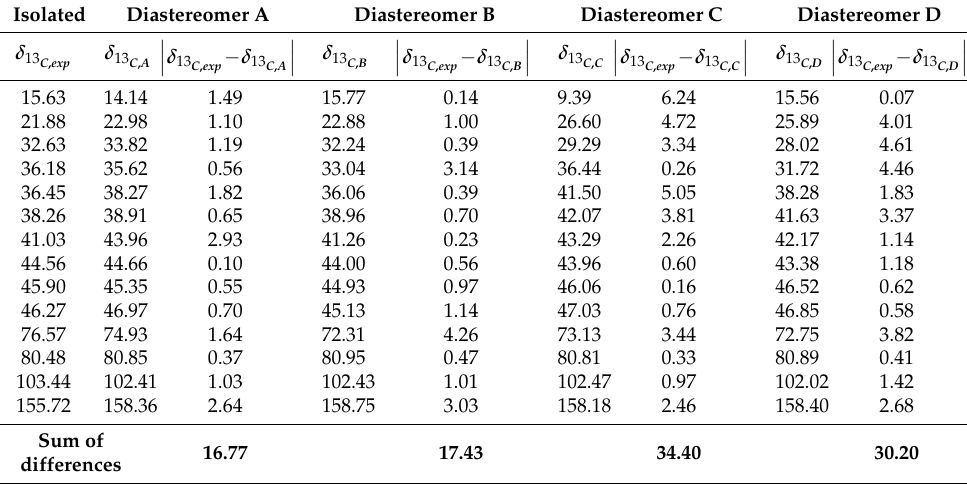
Figure 3. Proposed structures for the second compound isolated from the fermentation broth. Table 2. Comparison of experimental chemical shifts for the second isolated compound and GIAO 13 C-NMR chemical shifts calculated for proposed structures A–D (See also Supplementary Materials S2 for calculation details).